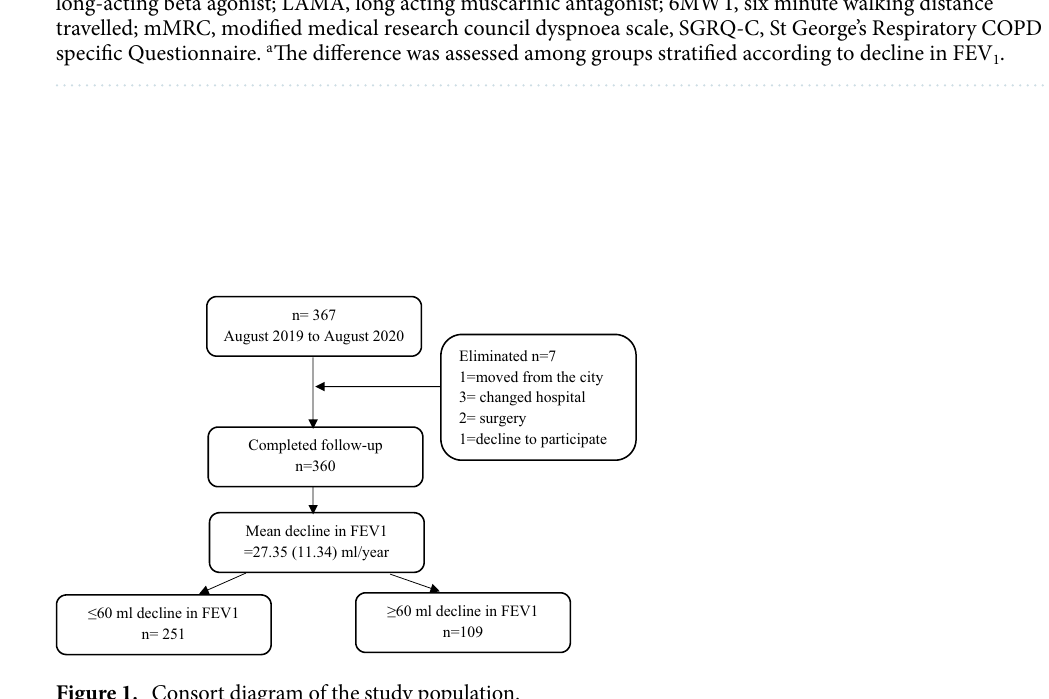
Figure 1. Consort diagram of the study